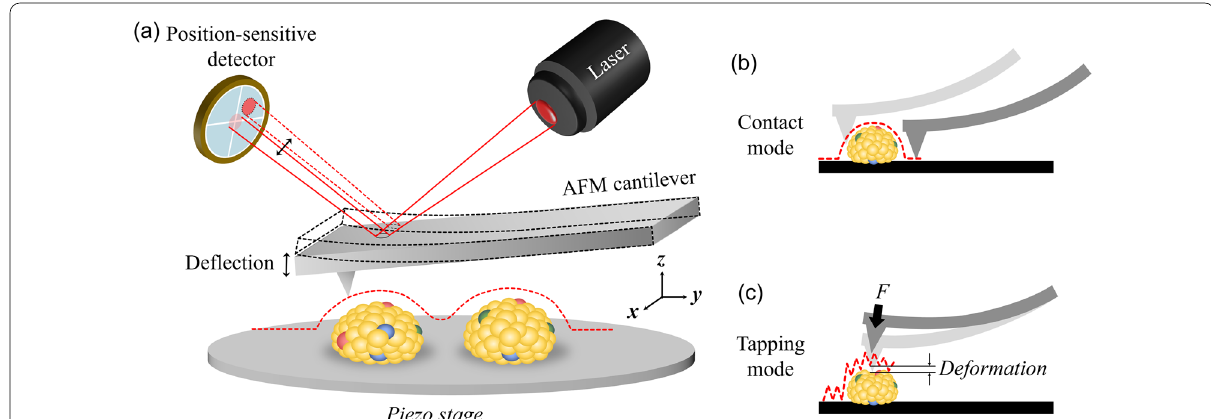
Fig. 5 Schematic diagram of atomic force microscopy (AFM). a Signal detection principle of AFM. b Contact mode of AFM obtains topographic data of the EV surface. c Tapping mode of AFM detects deformation of EV membrane and obtains mechanical properties, such as rigidity and adhesion by applying force through the